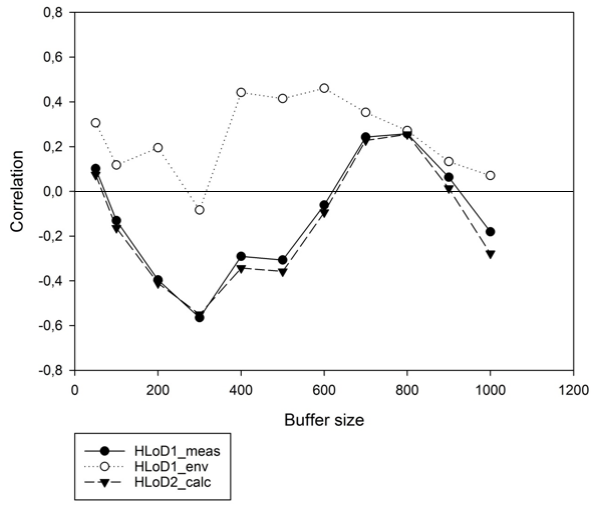
Figure 9. Correlation coefficients of the ‘averaged height of building’ from LoD1 with different measures and measured TNC values in different buffer sizes.